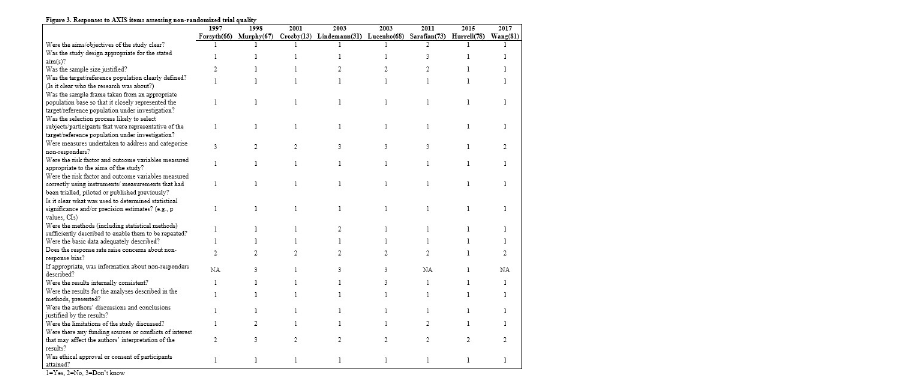
Fig 3. Responses to AXIS items assessing non-randomized study quality.